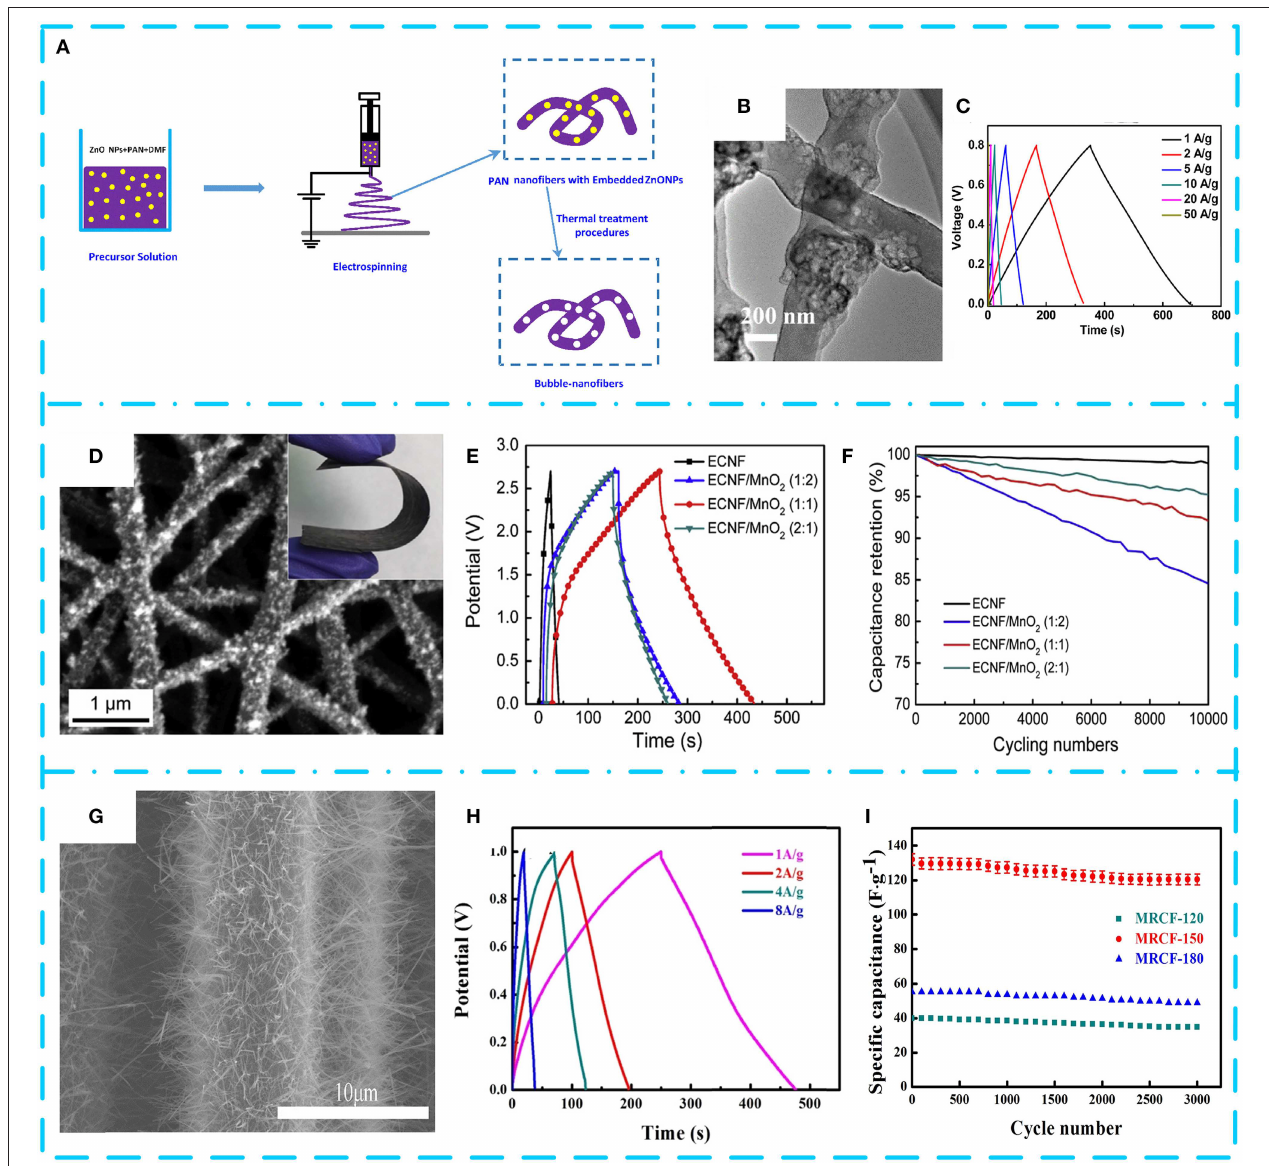
FIGURE 5 | (A) Schematic illustration of bubble carbon nanofibers (B-CNFs). (B) Transmission electron microscopy (TEM) image of B-CNF/MnO 2 composites with the B-CNFs calcined at 1,000 ◦ C. (C) Galvanostatic charge/discharge curves of B-CNFs/MnO 2 at different discharge current densities. Reproduced from Zhao H. et al. (2016) with permission from Pergamon. (D) Scanning electron microscopy (SEM) images of electrospun carbon nanofiber (ECNF)/MnO 2 (2:1). (E) Galvanostatic charge/discharge curves acquired from ECNF and three ECNF/MnO 2 mats/electrodes at current density of 250mA g − 1 . (F) Cycling stability/durability of the ECNF and three ECNF/MnO 2 mats/electrodes at high constant current density of 2,000mA g − 1 . Reproduced from Ma et al. (2016) with permission from Elsevier S.A. (G) SEM image of regenerated carbon fiber (RCF) prepared at 150 ◦ C. (H) Galvanostatic charge/discharge curves at different current densities of MnO 2 /RCF